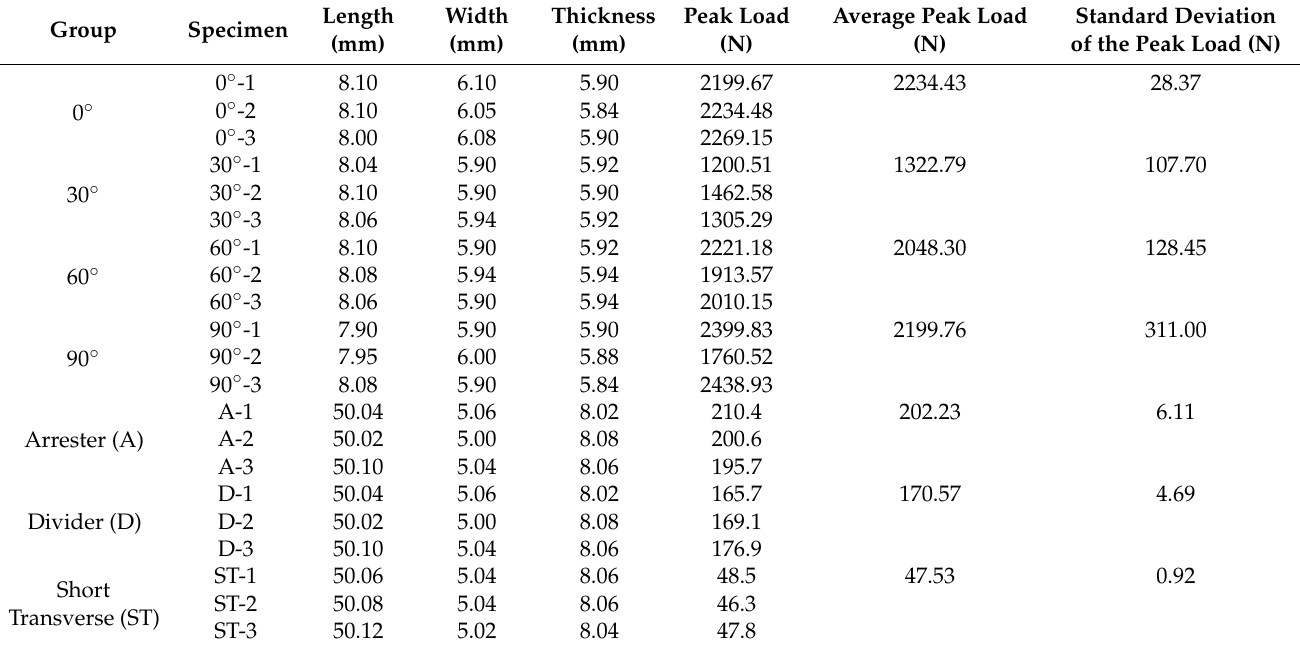
Table 2. The pretesting results for the compression test and three-point bending